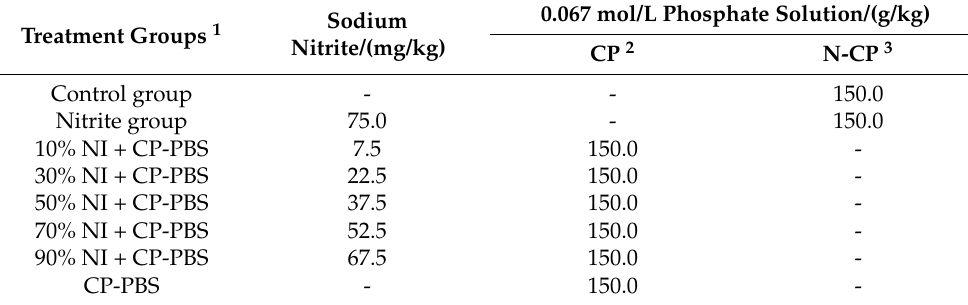
Table 1. Experimental